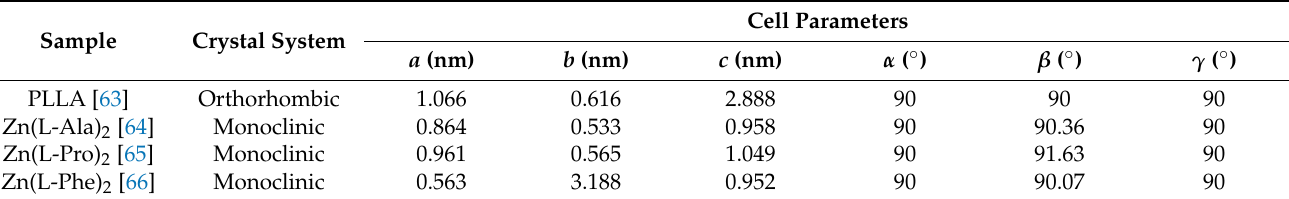
Table 5. Cell parameters of PLLA and zinc salts of amino